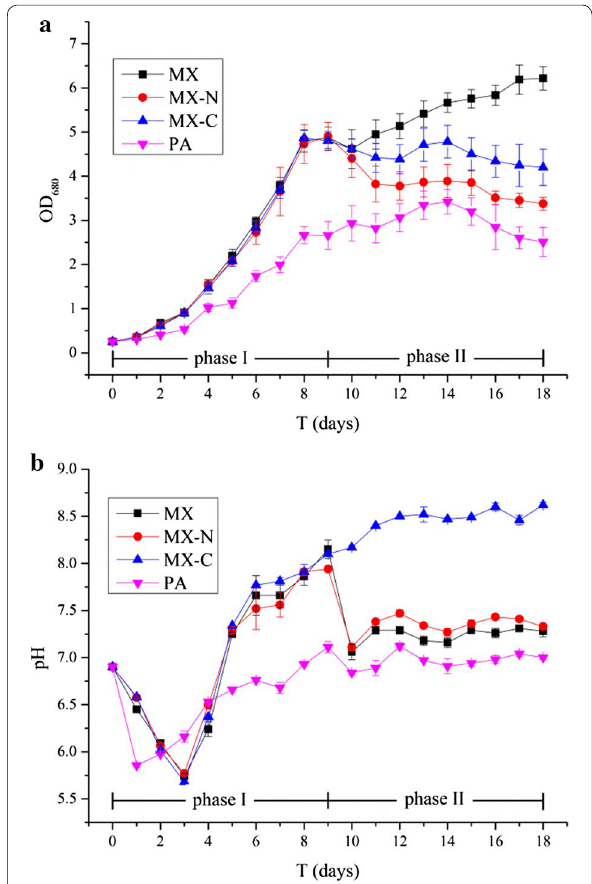
Fig. 2 Plots showing the time-dependent changes observed in: a the growth of C. vulgaris , and b pH of the culture during the cultivation period for the four treatment groups. Experiments were conducted in triplicate, and the results shown are the means (with standard deviations, n =